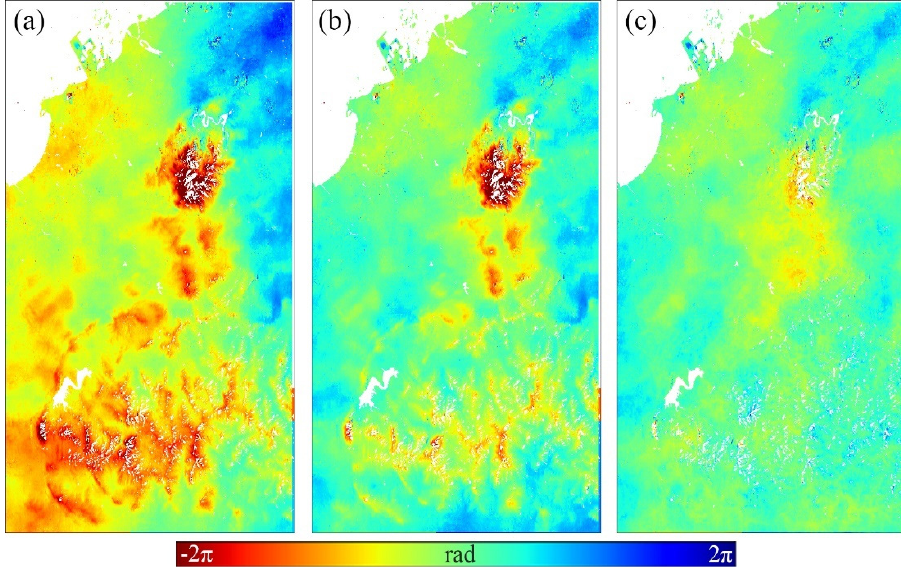
Figure 19. Example of atmospheric noise mitigation. ( a ) Original interferogram (27 April 2017–21 May 2017); ( b ) interferogram after linear detrending; and ( c ) interferogram after topography-correlated atmospheric phase correction.